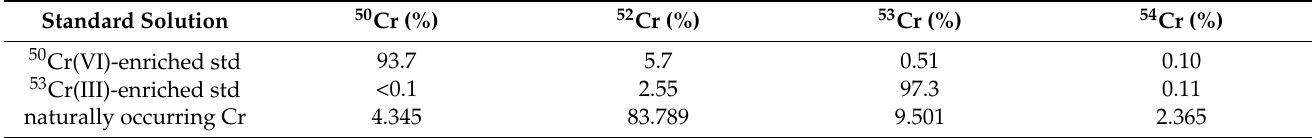
Table 1. Certified isotopic abundances (%) for the 50 Cr(VI)-enriched and the 53 Cr(III)-enriched standard solutions. For clarity, isotopic abundances of naturally occurring Cr are also reported. Standard